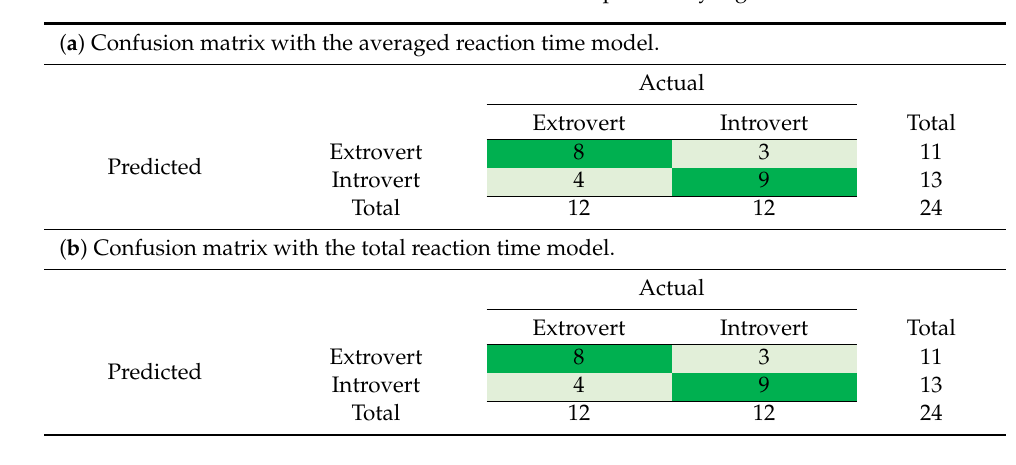
Table 4. Classification results of the developed binary logistic models.